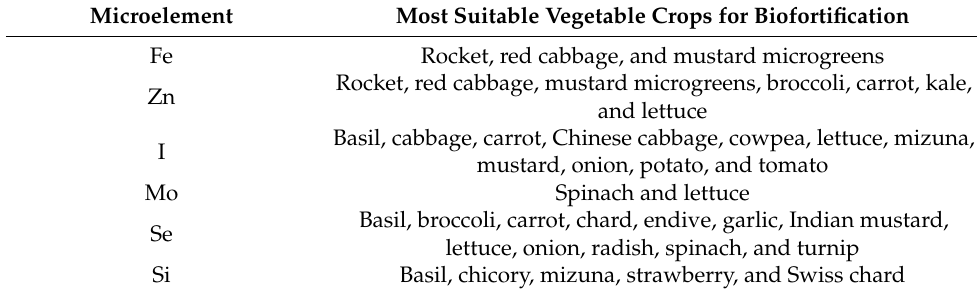
Table 1. Most suitable vegetable crops to agronomic biofortification (1)